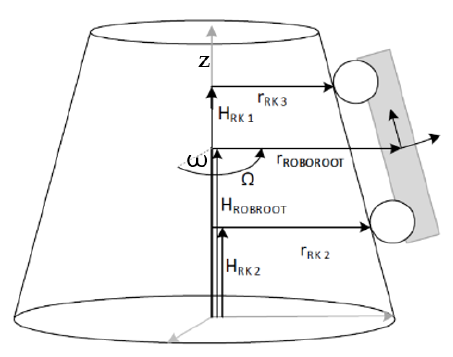
Figure 17. Magnetic platform.